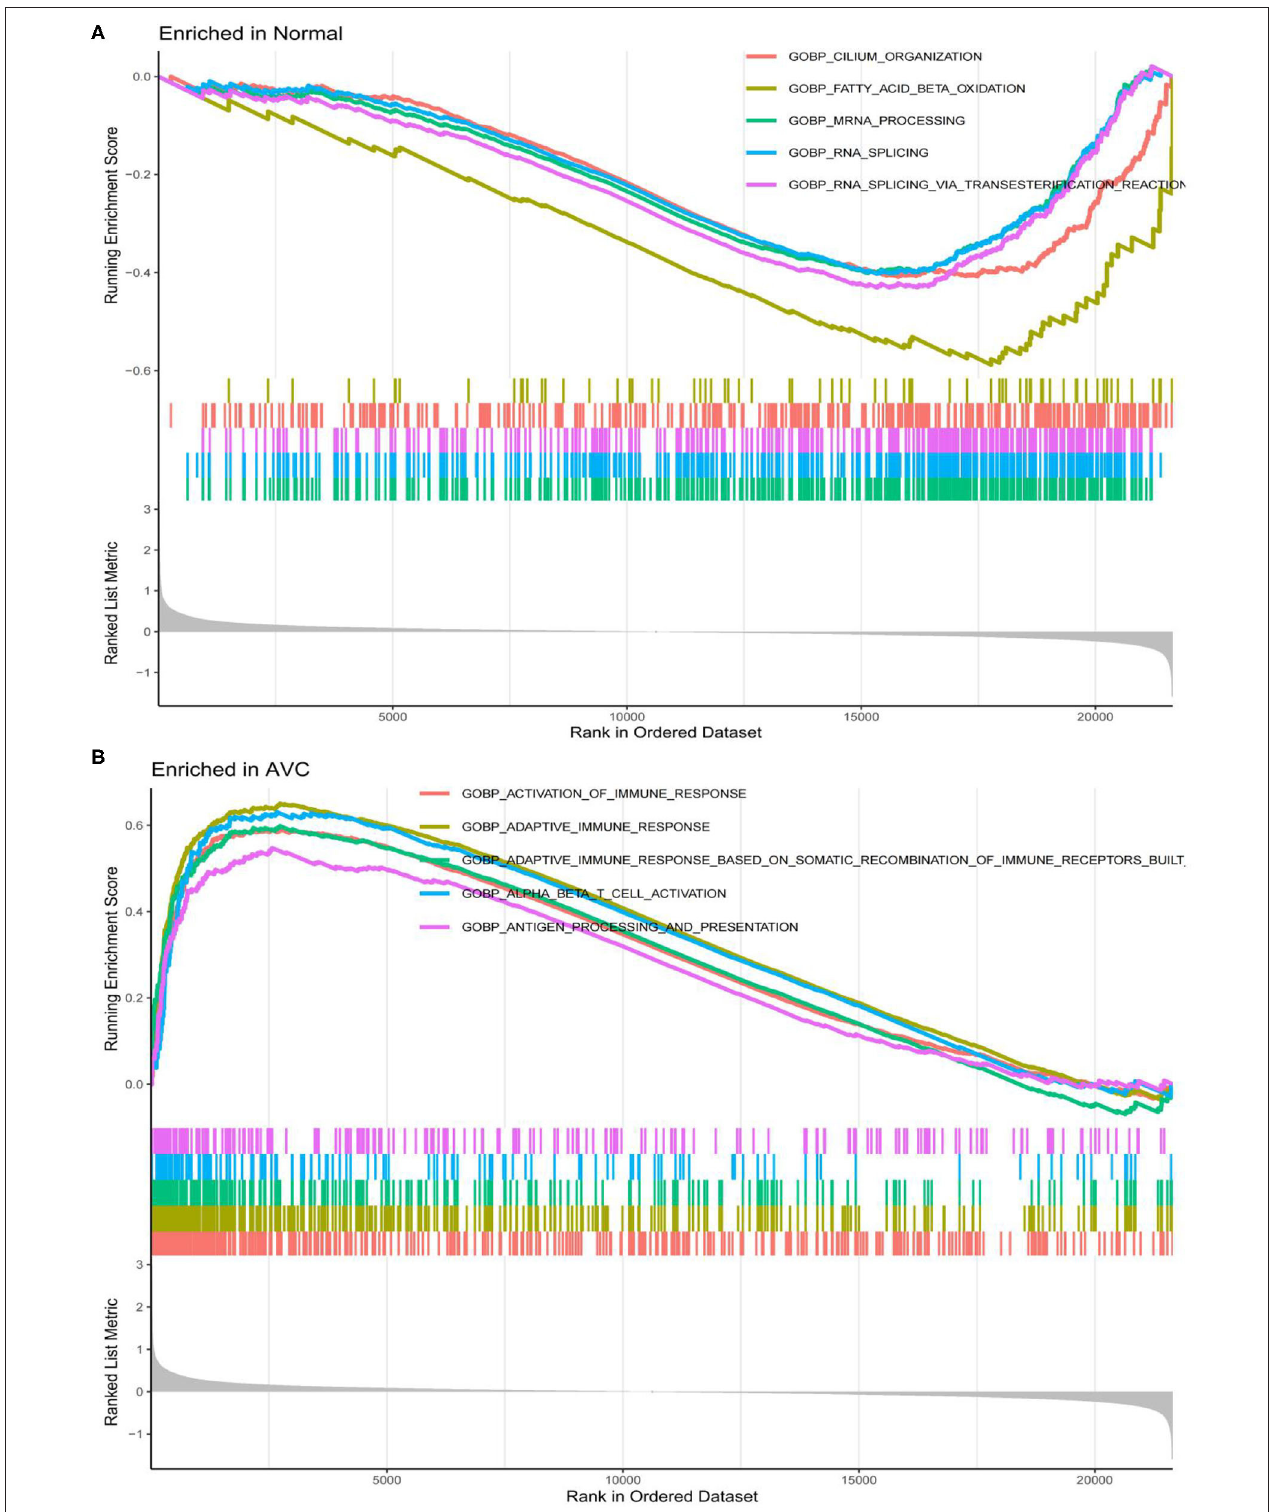
FIGURE 5 | LogFC values were calculated for all genes, and Gene set enrichment analysis (GSEA) analysis was performed based on logFC using c2.cp.kegg.v7.4.symbols.gmt and c5.go.v7.4.symbols.gmt in the normal and AVC groups using. (A) Analysis of the GO pathway terms for all genes enriched in the normal group using GSEA. (B) Analysis of the GO pathway terms for all genes enriched in the AVC group using GSEA.